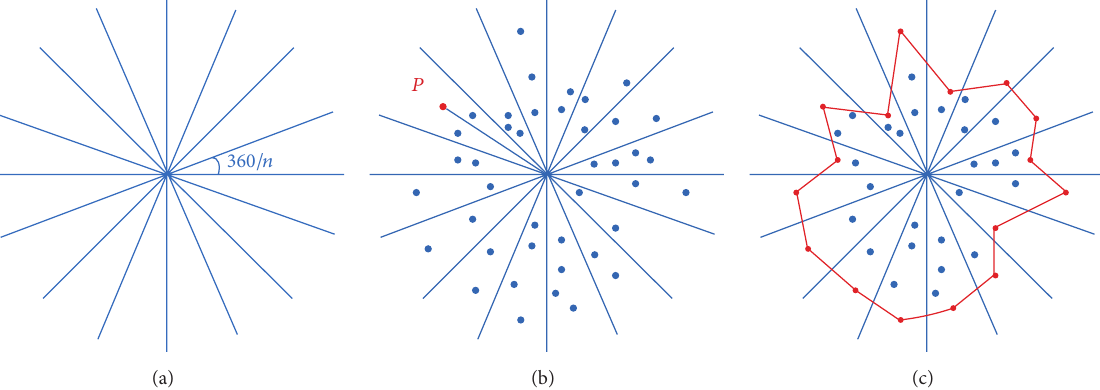
Figure 9: Process of the boundary identifying method. (a) Division of coordinate system, (b) selection of border points, and (c) connection of border